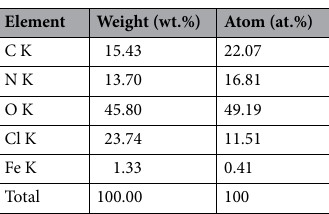
Table 1. EDS element contents of laminated AP